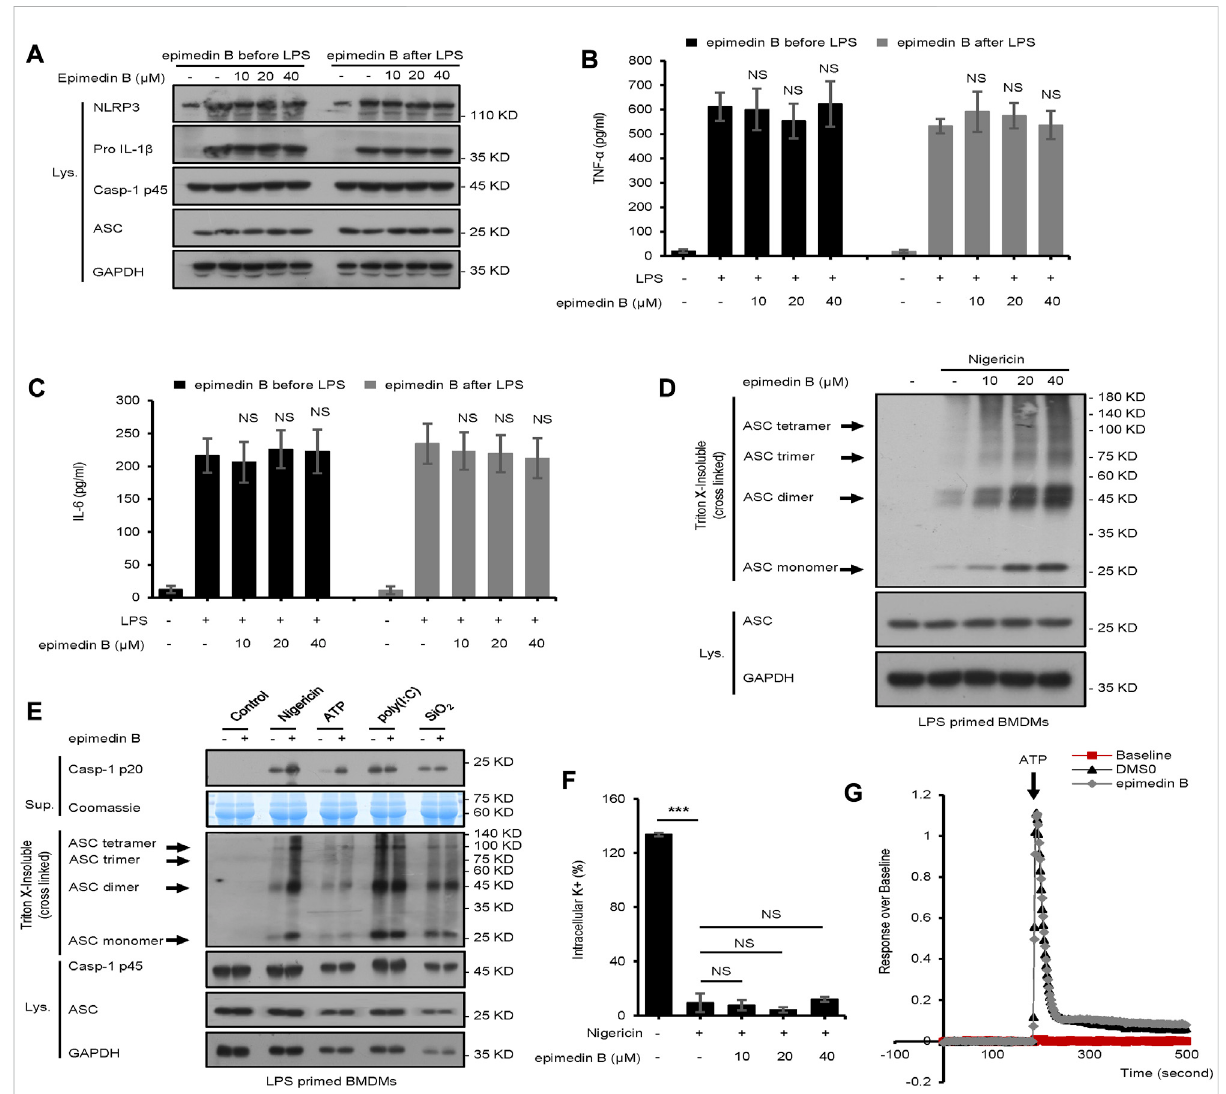
FIGURE 5 Epimedin B promotes ATP or nigericin-induced ASC oligomerization but does not block K + ef fl ux and Ca 2+ fl ux. (A) Western blot analysis of whole-cell lysates from bone marrow-derived macrophages (BMDMs) subjected to treatment with epimedin B for 1 h, and stimulated with lipopolysaccharide (LPS) (50 ng/ml) for 3 h or BMDMs were stimulated with LPS (50 ng/ml) for 3 h and then subjected to treatment with epimedin B for 1 h (B,C) ELISA of TNF- α (B) and IL-6 (C) in Sup derived from samples described in (A) (D) Western blot analysis of ASC oligomerization from LPS-primed BMDMs subjected to treatment with various doses of epimedin B prior to nigericin stimulation. (E) Western blot analysis of ASC oligomerization from LPS-primed BMDMs subjected to treatment with epimedin B and stimulated with nigericin, ATP, SiO2, and poly (I:C). (F) Quanti fi cation of potassium ef fl ux in LPS-primed BMDMs subjectedto treatmentwith various doses of epimedin B and stimulated with nigericin. (G) AtraceofATP-inducedCa 2+ fl uxwasmeasuredusingtheFLIPRTETRA systeminLPS-primedBMDMssubjectedtotreatmentwithepimedin (B) .Data are presented as the mean ± SD from at least three biological samples. The signi fi cance of the differences was analyzed using unpaired Student ’ s t -test: * p < 0.05, ** p < 0.01, *** p < 0.001, NS: not signi fi